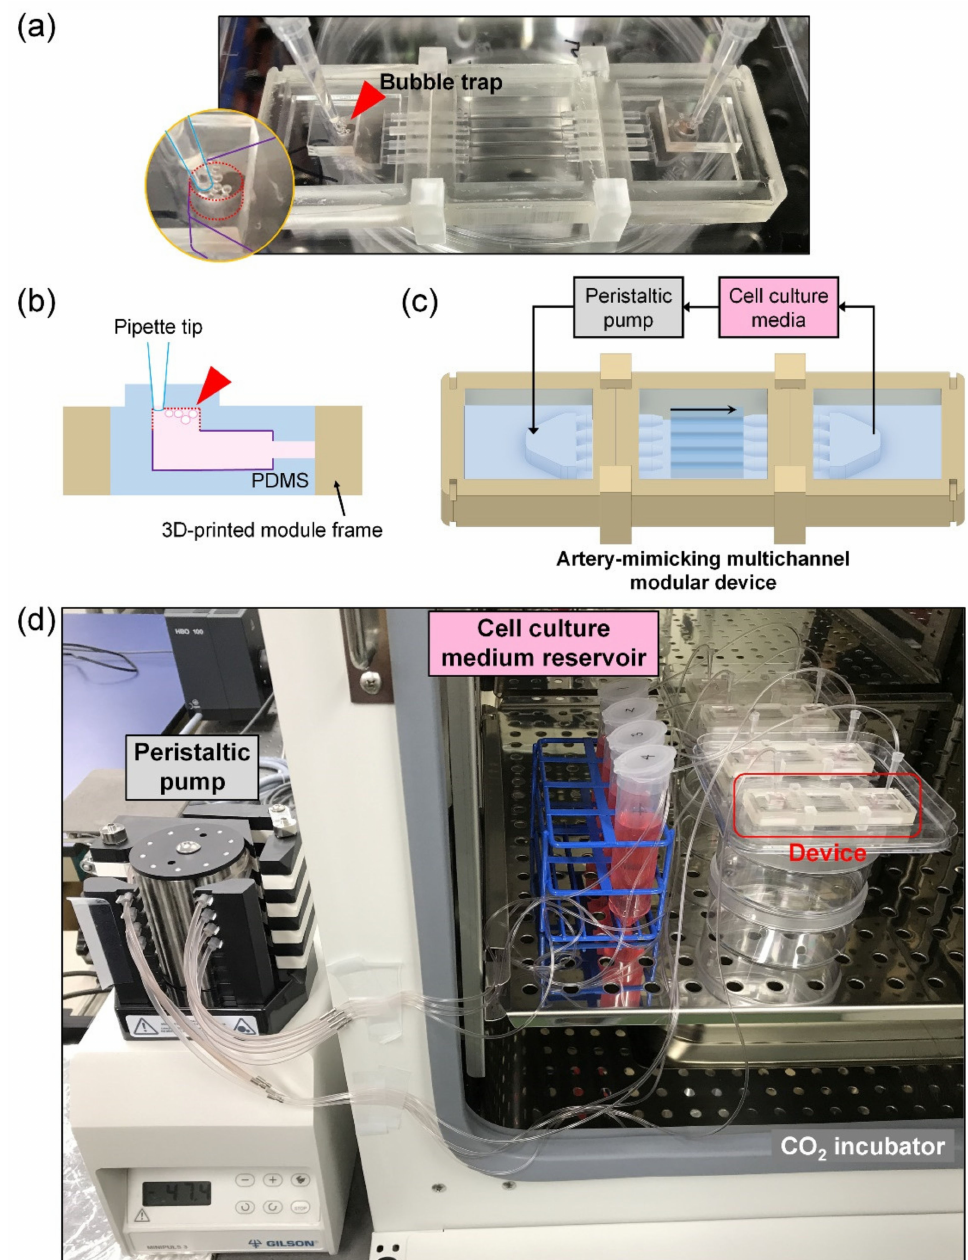
Figure 3. An overall operating system for modular 3D in vitro multichannel devices. ( a ) Photo of the modular 3D in vitro artery-mimicking multichannel device. The in vitro artery-mimicking multichannel module was connected with two chamber modules back and forth in a modular device for the coculture of cells. The bubble trap in the chamber module is shown in a magnified image. ( b ) Cross-sectional side view of the chamber module. The module was a hybrid of PDMS and a three-dimensionally printed frame. Bubbles, which could disturb the medium flow, block channels and interfere with the adhesion and culture of cells on the channel surface, were collected in the bubble trap. Scheme ( c ) and photograph ( d ) of the overall system. Four to eight modular devices were operated simultaneously in a high-throughput